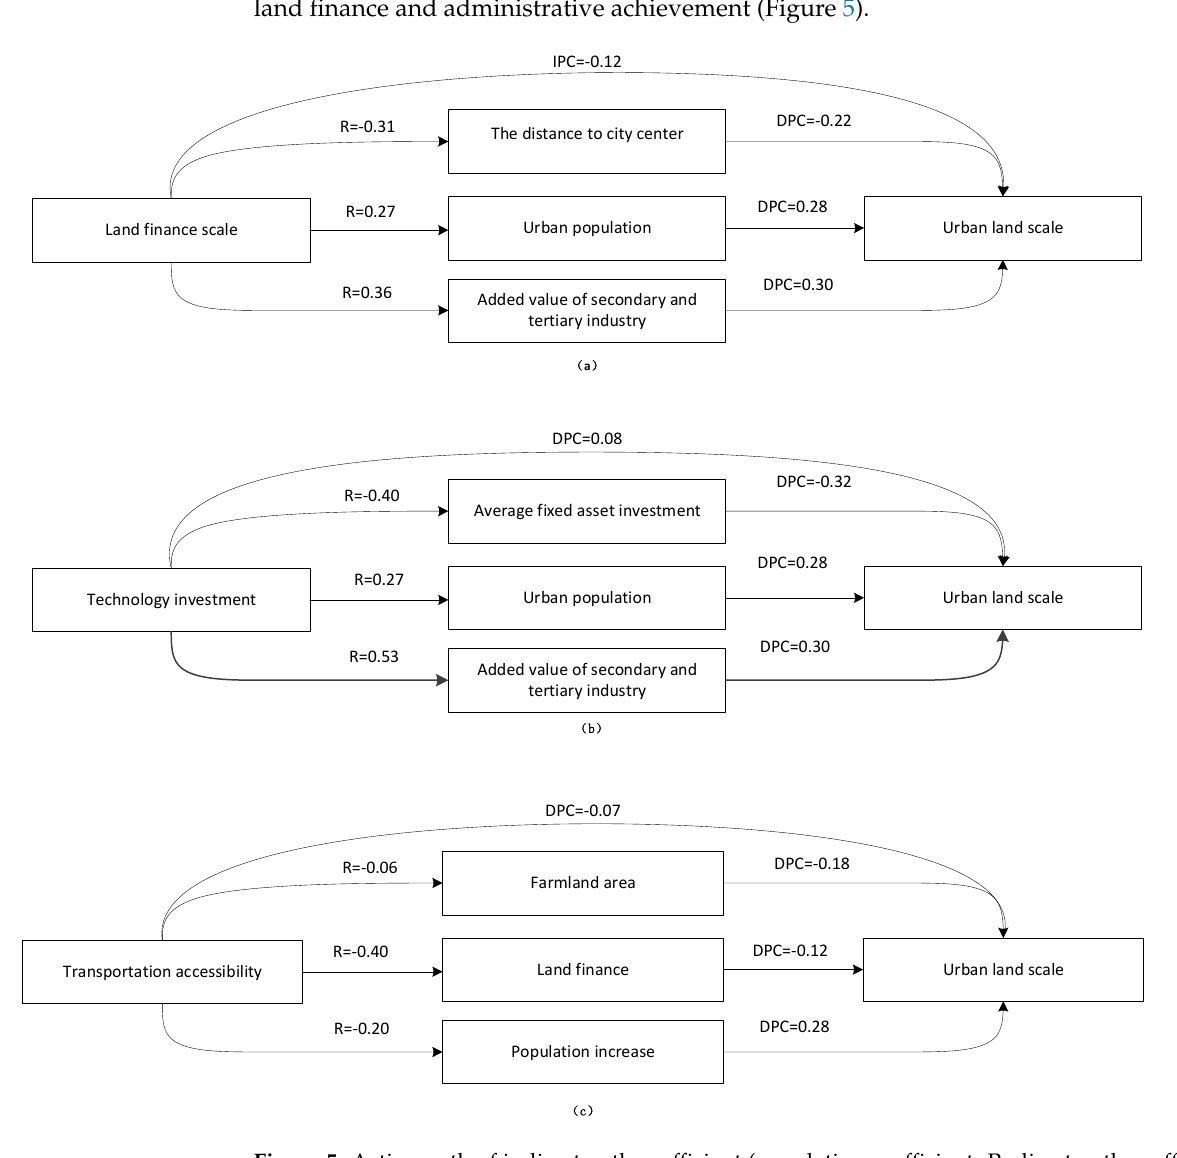
Figure 5. Action path of indirect path coefficient (correlation coefficient: R; direct path coefficient: DPC). Note: ( a ): The direct and indirect influence path of land finance scale on urban land scale. ( b ): The direct and indirect influence path of technology investment on urban land scale. ( c ): The direct and indirect influence path of transportation accessibility on urban land scale.